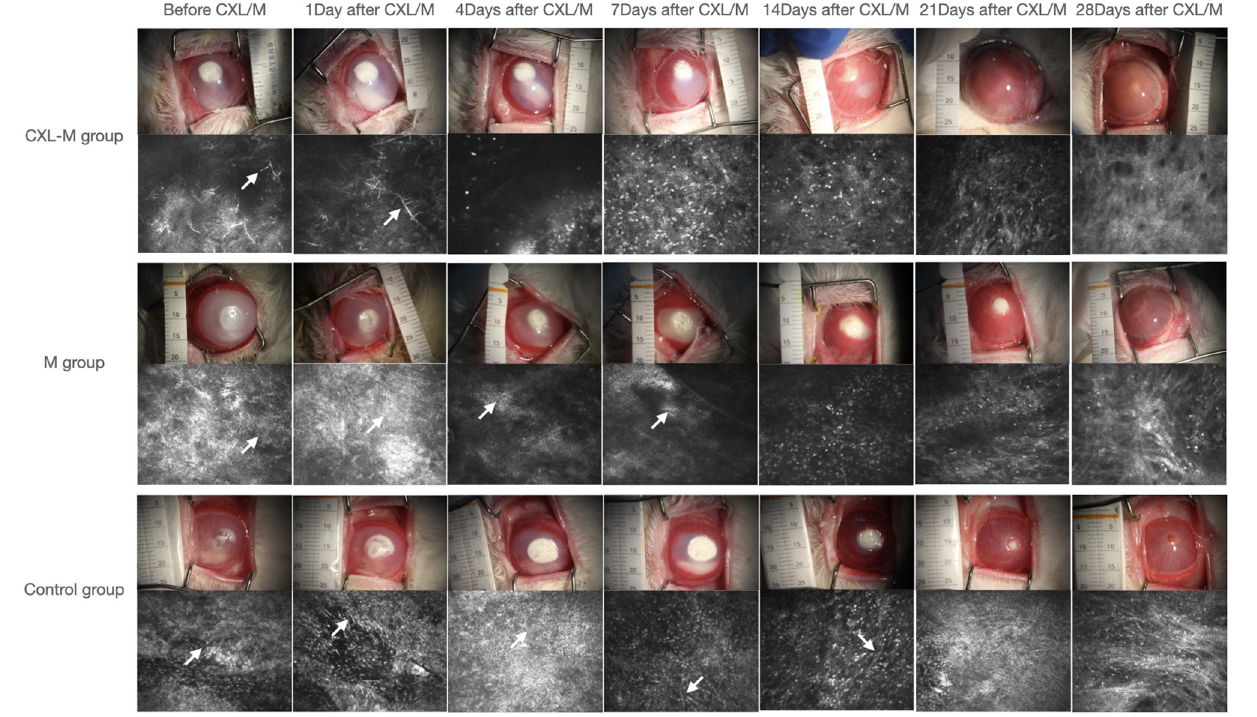
FIGURE 1 | Representative images of the corneal ulcer of a representative rabbit and its corresponding IVCM in each group at all follow-up periods. The white arrow shows the fungal hypha.